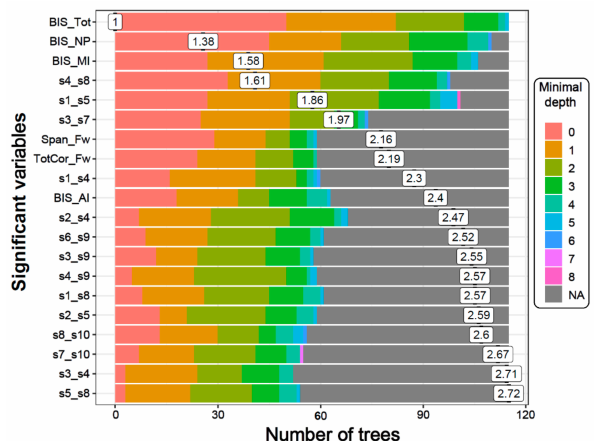
Figure 3. The distribution of minimal depth among the trees of the forest for the significant variables is shown in di ff erent colors for each level of minimal depth. The mean minimal depth in the distribution for each variable is marked by a vertical black bar overlapped by its value inside a box. A lower mean minimal depth of a functional connectivity (FC) variable represents a higher number of observations (participants) categorized in a specific group on the basis of the variable. The top significant variables (14 DMN connections, two neuropsychological scores, and all four BIS scores) followed the same rank in the plot as in Table 3, which is ordered based on p -values.